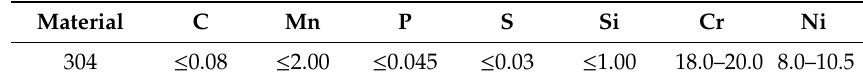
Table 1. Chemical composition of S30408 (wt.%).